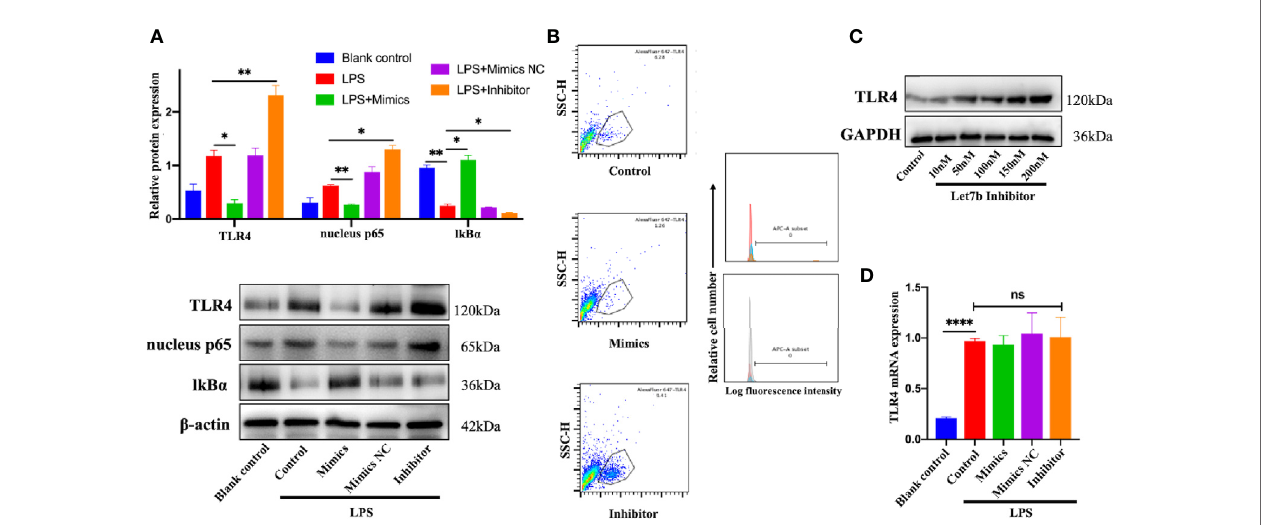
FIGURE 2 | miR-let-7b activates the TLR4/NF- k B signaling and inhibits TLR4 expression via post-transcriptional regulation. (A) Neutrophils treated with 100 ng/mL LPS were then co-incubated with miR-let-7b mimics, miR-let-7b inhibitor, and miR-let-7b mimics NC (100 nM, respectively) for four hours followed by Western blotting to detect TLR4, nucleus p65, and cytosolic IkB a . *P < 0.05, **P < 0.01. (B) Isolated neutrophils were incubated with LPS alone or with indicated concentrations of miR-let-7b mimics and inhibitor (100 nM, each) for four hours followed by measurement of TLR4 binding (staining with AF647) by fl ow cytometry. The blue line is AF647-stained neutrophils cultured for four hours only (Blank), the red line is AF647-stained neutrophils pretreated with LPS and then cultured for four hours (Control), the brown line is AF647-stained neutrophils pretreated with LPS and then cocultured with miR-let-7b mimics for four hours (Let-7b mimics), and the gray line is AF647-stained neutrophils pretreated with LPS and then cocultured with miR-let-7b inhibitor for four hours (let-7b inhibitor). (C) A dose-dependent increase of TLR4 protein was determined with miR-let-7b inhibitor treatment. (D) RT-qPCR of miR-let-7b expression in human neutrophils. ****P < 0.0001, not signi fi cant (ns). All traces are representative of ≥ 3 independent experiments. Data represent mean ± SD (n=3).